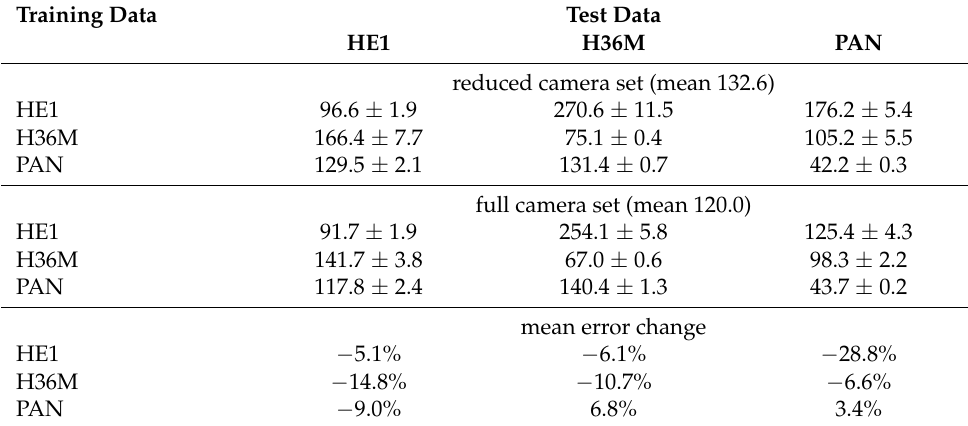
Table 8. Errors with the reduced vs. the full camera set (no-alignment errors in mm, mean ± std. deviation).